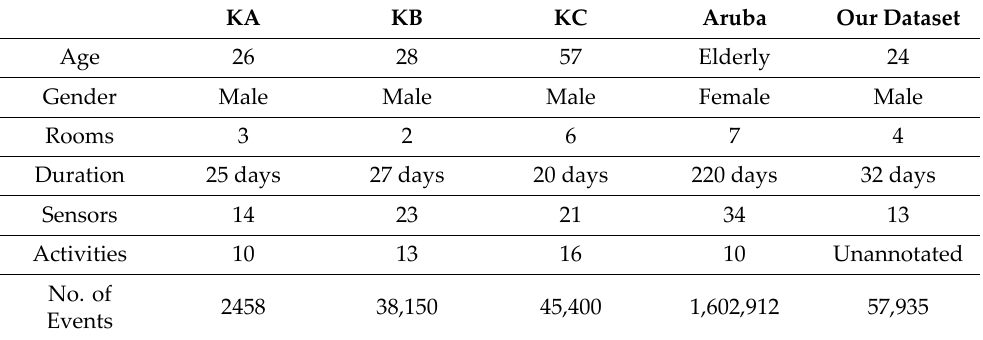
Table 2. Details of datasets.